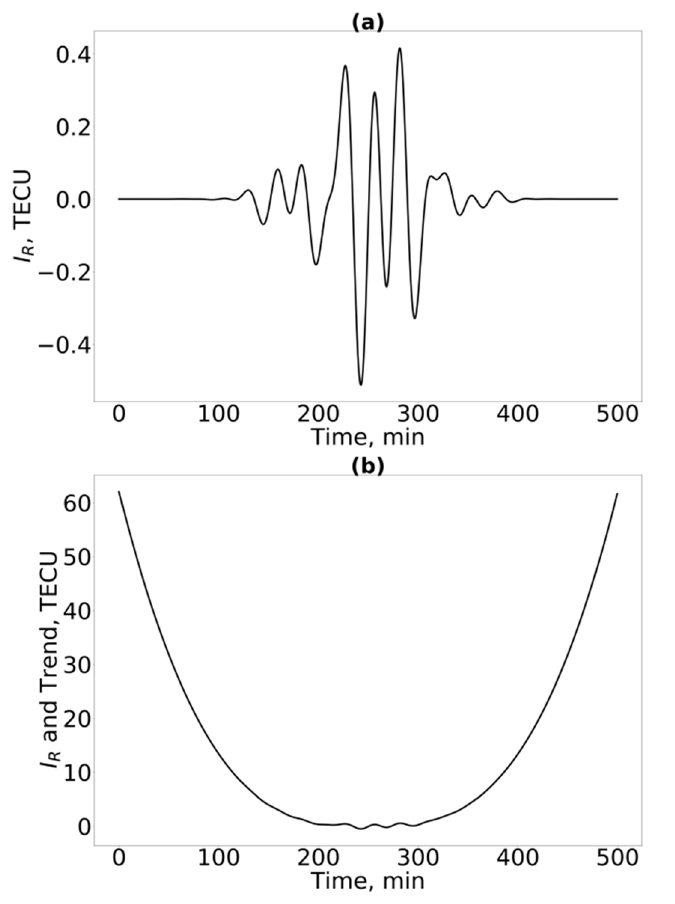
Figure 3. Model for the I R signal ( a ) and the trended signal ( b ). On the bottom panel signal is in the middle (minimum) of the trend.